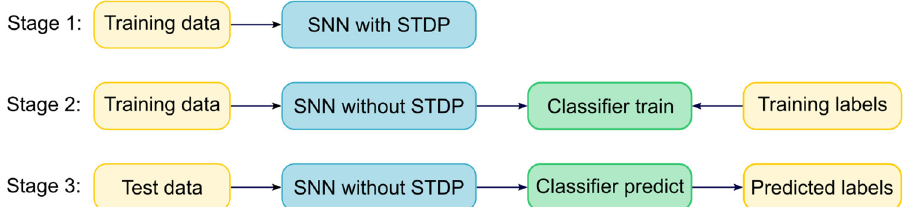
corresponding labels in the training set, i.e. training labels, which are the corresponding labels of currently processed input samples, are used to train the classifier. Finally, the classifier is run to predict the labels of the test data, which are called as predicted labels. The classification accuracy of the model is evaluated by comparing the predicted labels with the corresponding ground truth